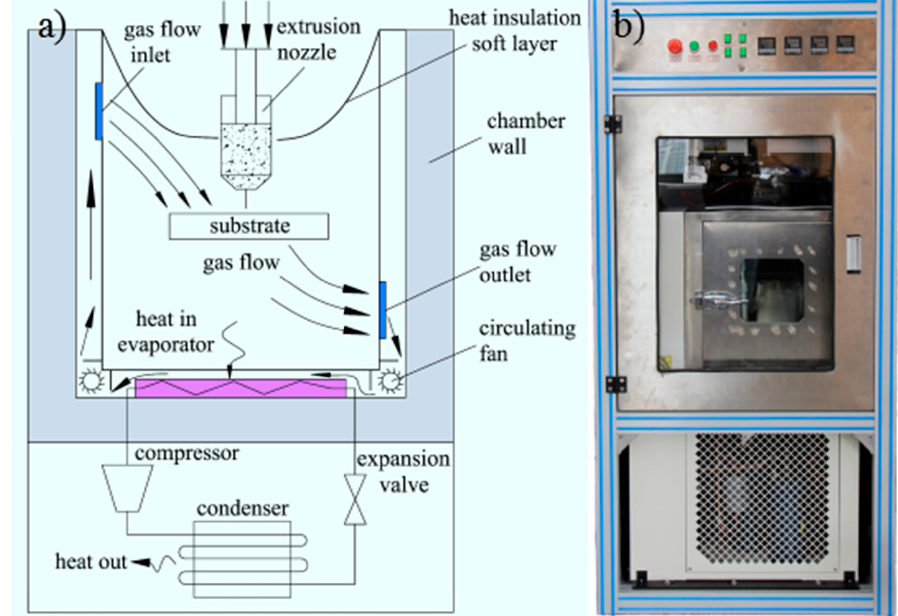
Figure 2. Schematic and image of the LTDW machine. ( a ) Schematic of the LTDW machine, ( b ) the LTDW machine.